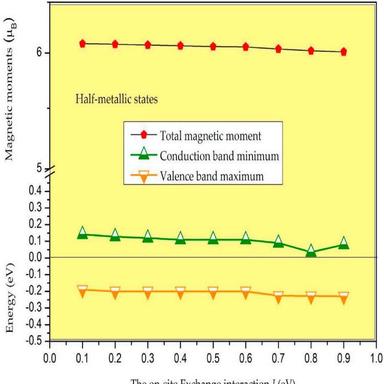
The effect of different on-site exchange constant J values on the electronic structures and magnetic moments (U ¼ 6.4 eV).